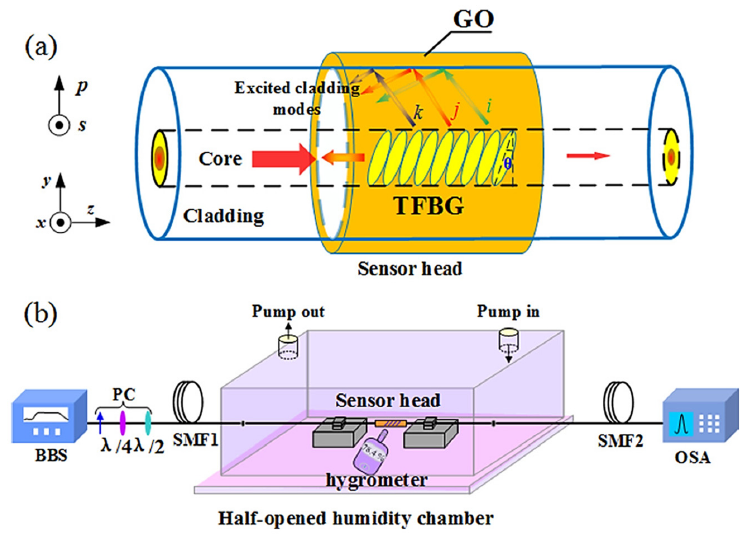
Figure 24. Point sensor. ( a ) Schematic of the sensing fiber. ( b ) Experimental setup. Reprinted with permission from ref. [116]. Copyright 2016 AIP